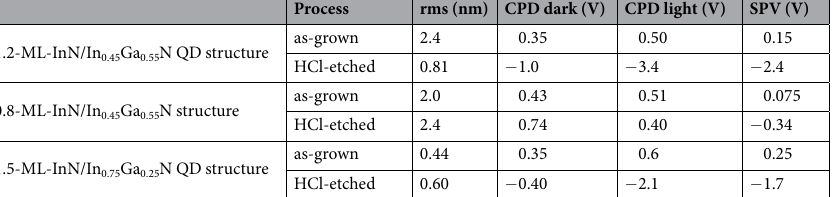
Table 1. Process and KPFM results. AFM root-mean-square (rms) roughness, contact potential difference (CPD) in the dark and light, and surface photovoltage (SPV) for the as-grown and HCl-etched 1.2-ML-InN/